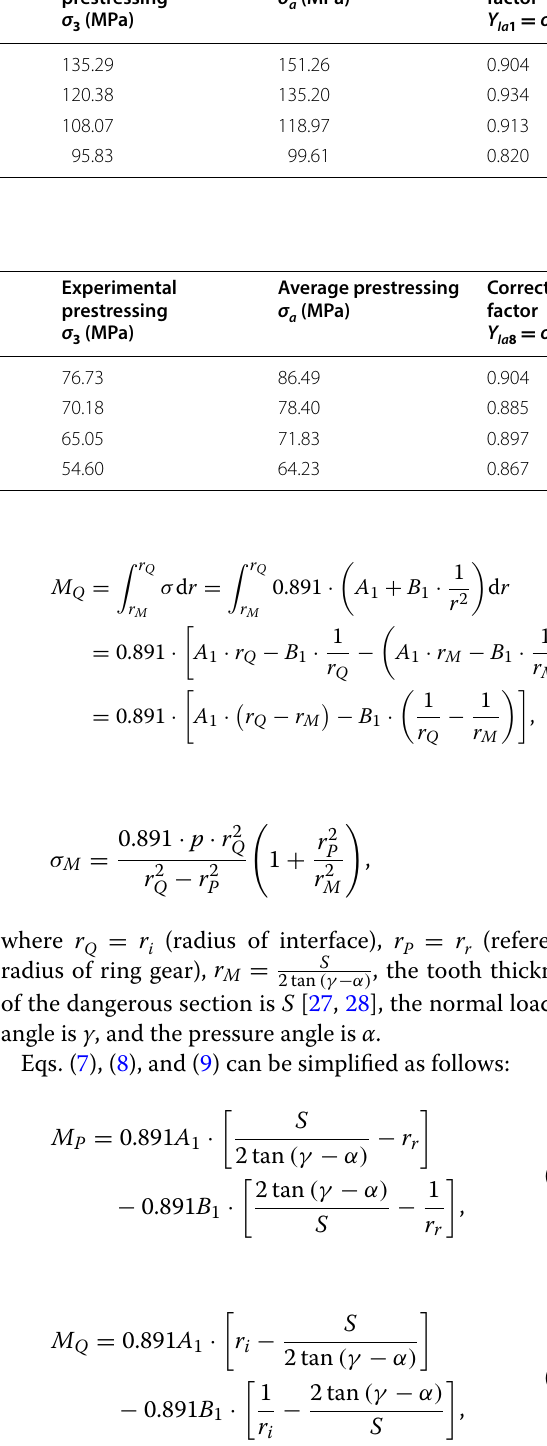
in experiment 1 Ia 1 Theoretical prestressing σ 1 (MPa)